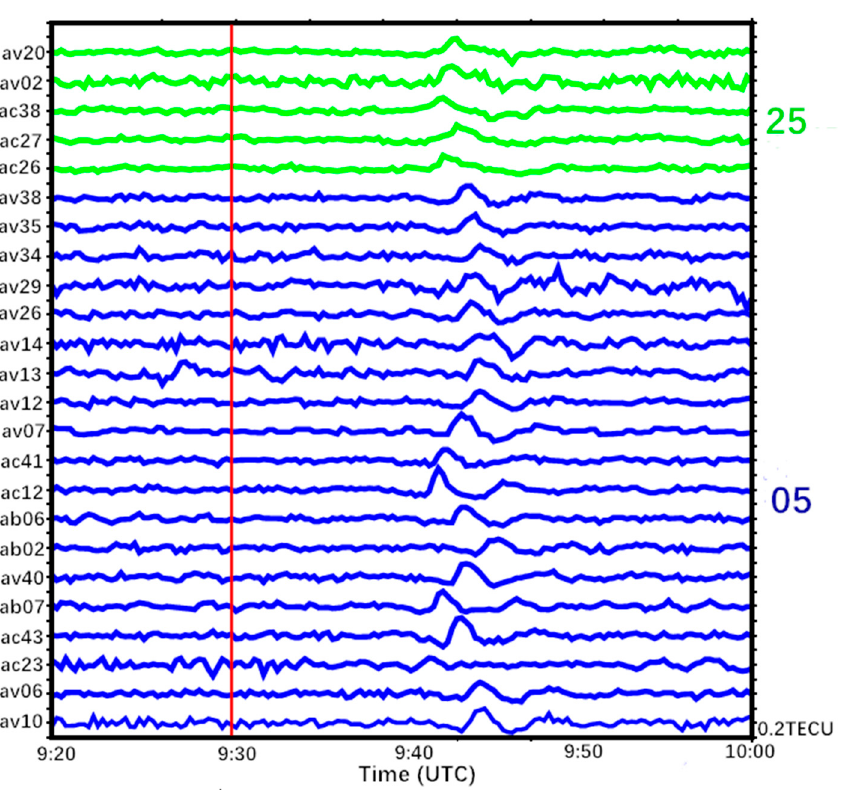
Figure 4. Ionospheric disturbance along LOS between the stations near the epicenter and the GPS satellites following the Alaska earthquake. The red line represents the shock time, name of receiver and GPS satellites are listed on the side of plot, and the scales 0.2 TECU refer to the y axis tick spacing.